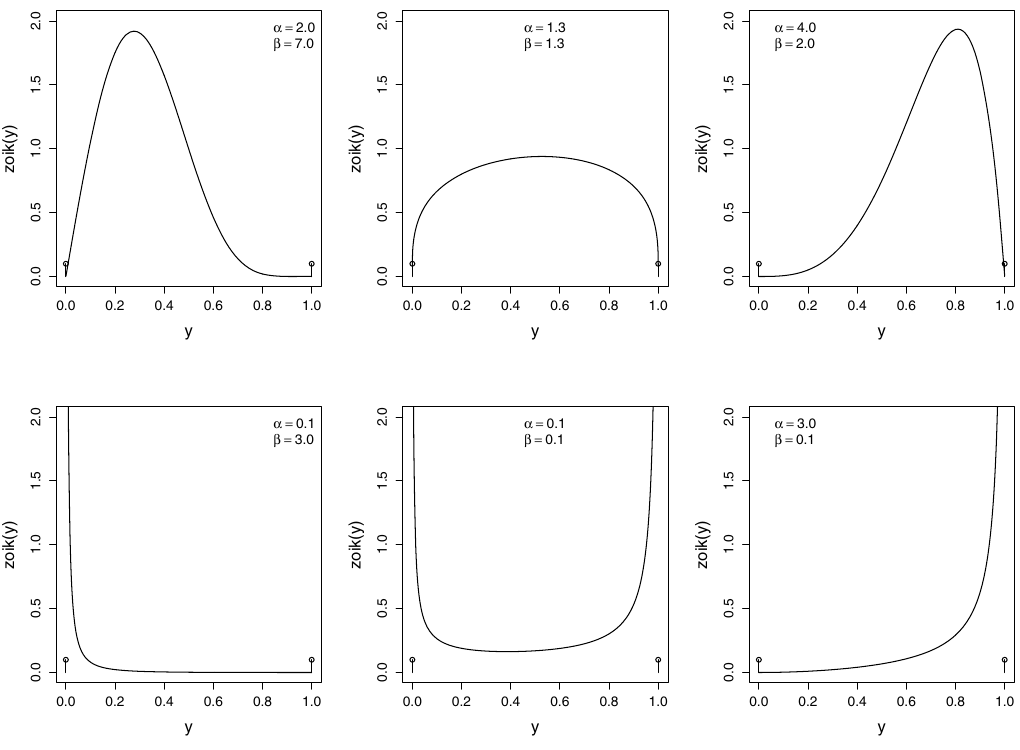
Figure 2 - Zero and one inflated Kumaraswamy densities, λ = 0.2 and p = 0.5